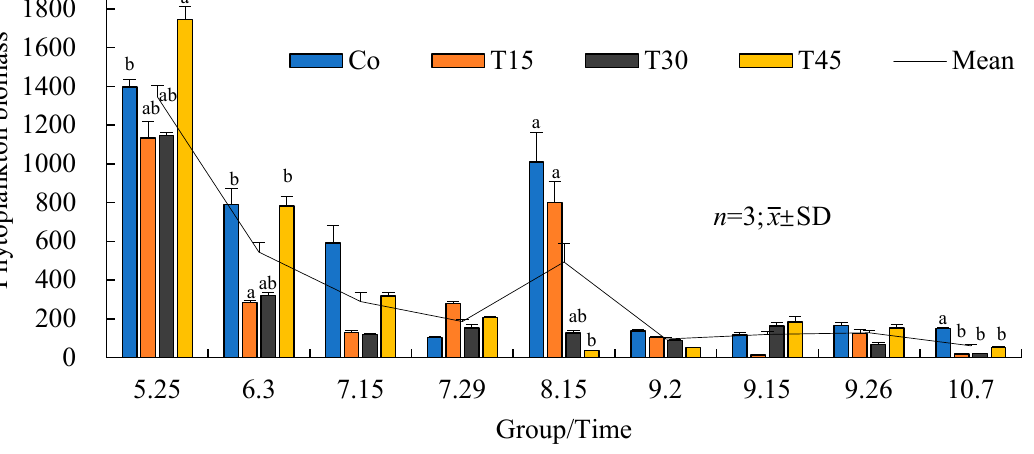
Figure 6. Phytoplankton biomass in different treatment groups during the experiment. Different lowercase letters in each group represent significant differences ( p < 0.05).